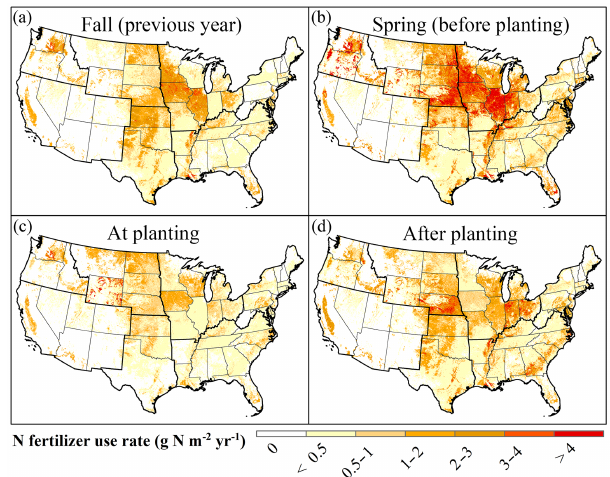
Figure 4. Geographic distribution of the N application rate in the four application timings during the year 2015: (a) fall (previous year), (b) spring (before planting), (c) at planting, and (d) after